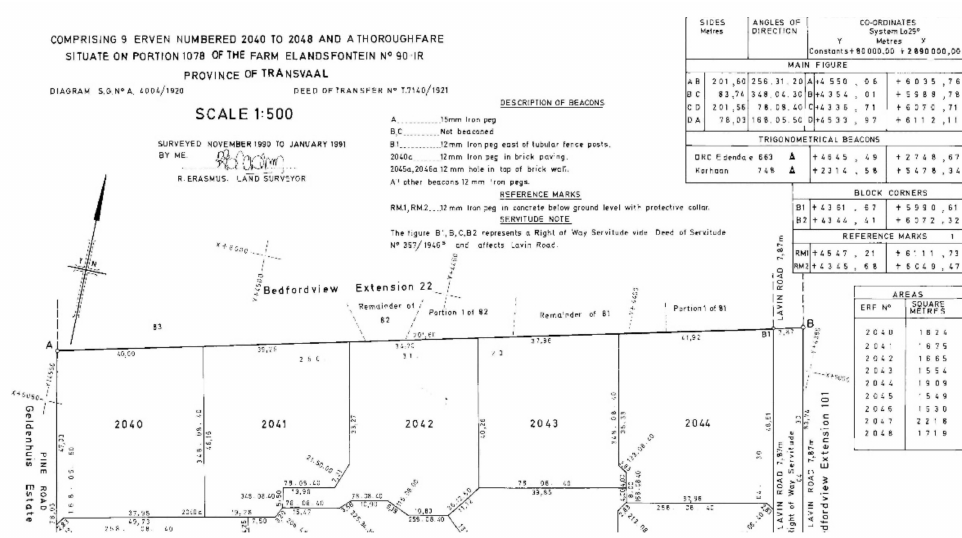
Figure 6. An example of a general plan indicating 9 erven in the formal cadastral system in a suburb known as Bedfordview, City of Johannesburg, in the Gauteng Province. Documents such as this are readily obtainable from the Cadastral Spatial Information dataset [16] (Ref: S.G. No. A.